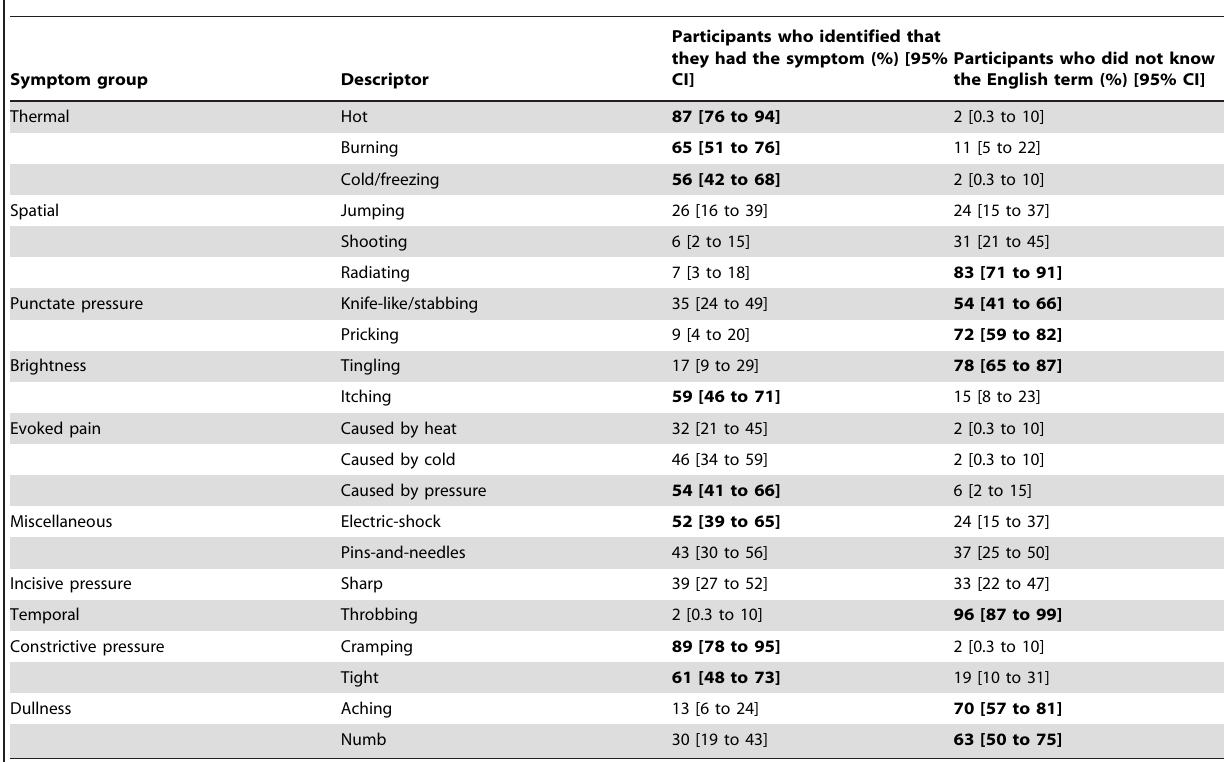
Table 4. Identification and knowledge of English neuropathic